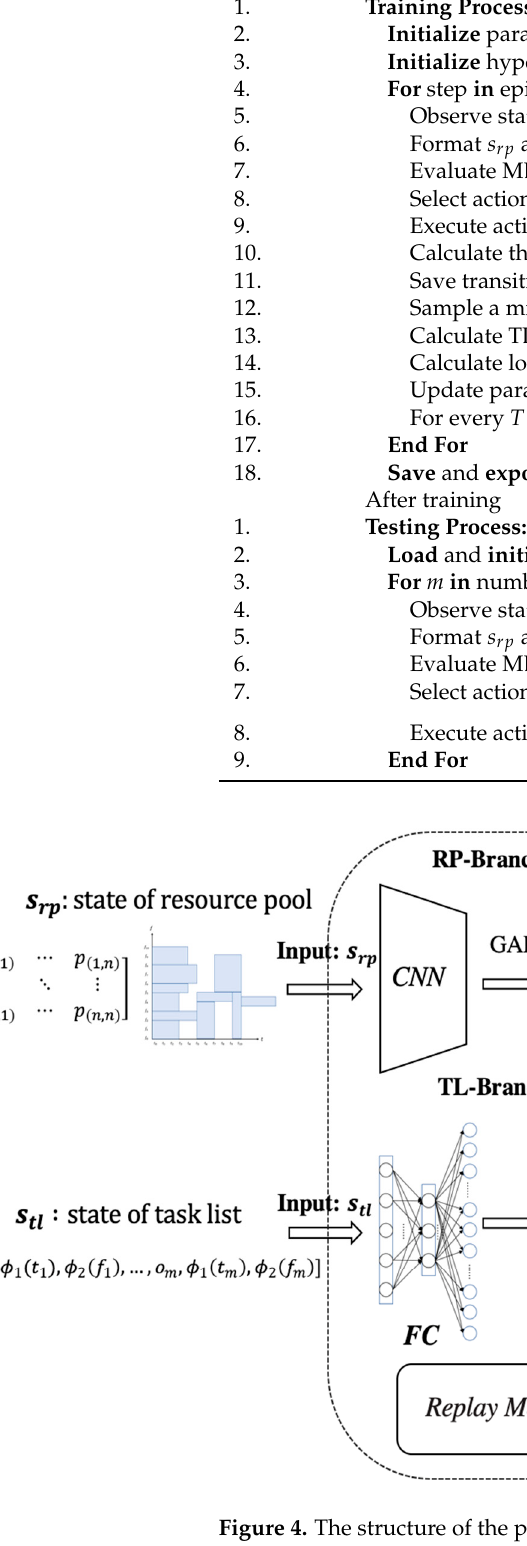
Figure 4. The structure of the proposed MBDQN resource allocation model.